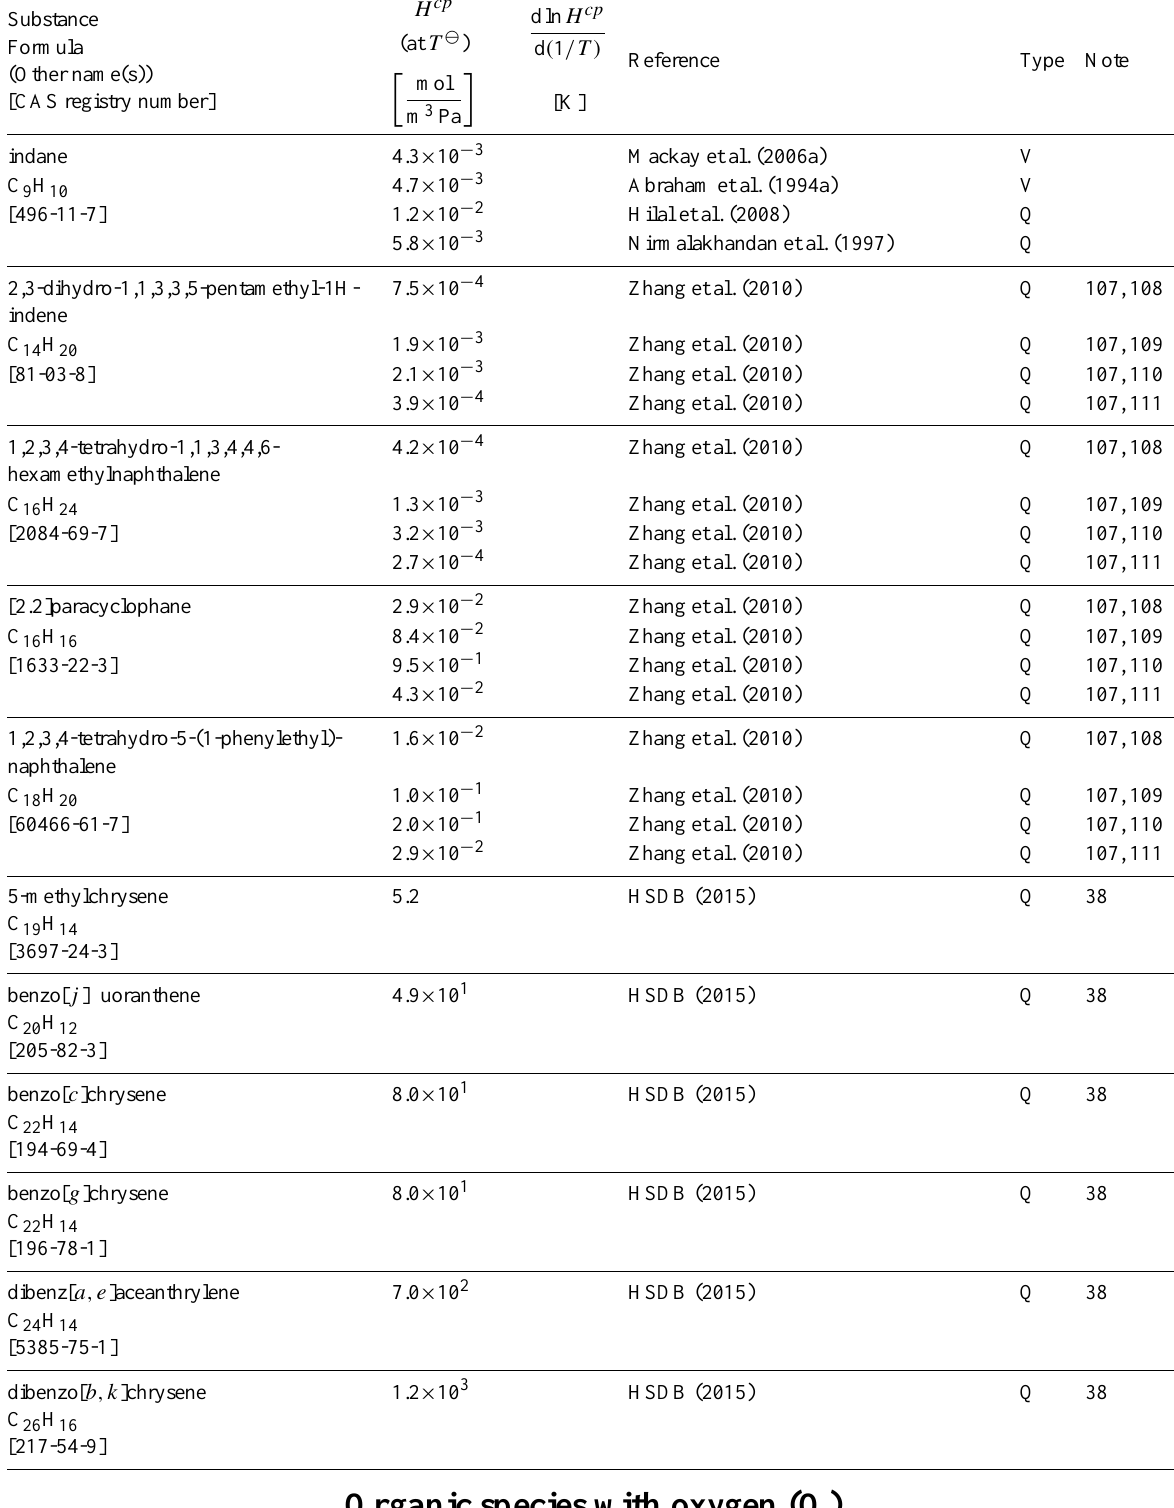
Table 6: Henry’s law constants for water as solvent